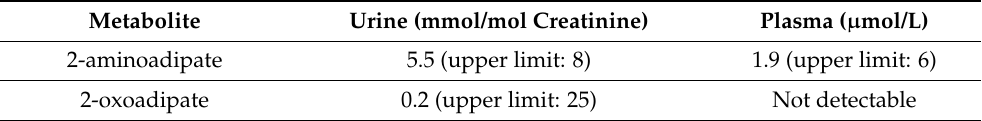
Table 3. Metabolite levels in sporadic ALS patient VALS164 carrying the DHTKD1 :c.2185G>A p.(Gly729Arg)